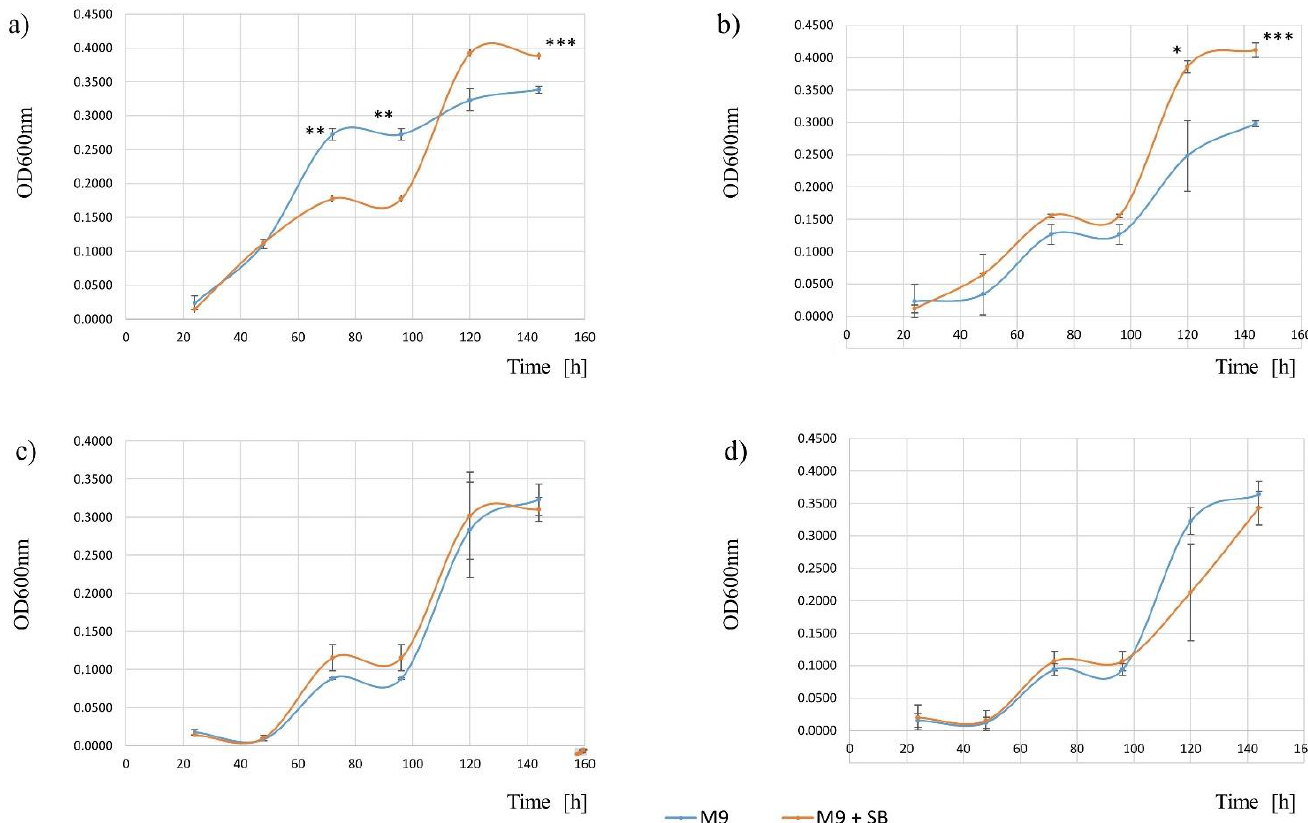
Figure 2. Effect of the 1% supplementary blend addition (D-malic acid, N-acetyl-D-glucosamine, α -keto-glutaric acid, γ - aminobutyric acid) on the growth of bacteria during 144 h of culturing in the M9 medium. Figures represent OD600nm measured during cultivation every 24 h for particular strains of bacteria accordingly: ( a ) Rhodococcus sp. B12/18, ( b ) Pseudomonas sp. B37/18, ( c ) Arthrobacter sp. B58/18, ( d ) Rhodococcus sp B75/18; n = 3, error bars represent standard sample deviation. Stars represent the level of significance ( p -value) of the differences within the particular hour. Three stars— p -value < 0.001, two stars— p -value < 0.01, one star— p -value <